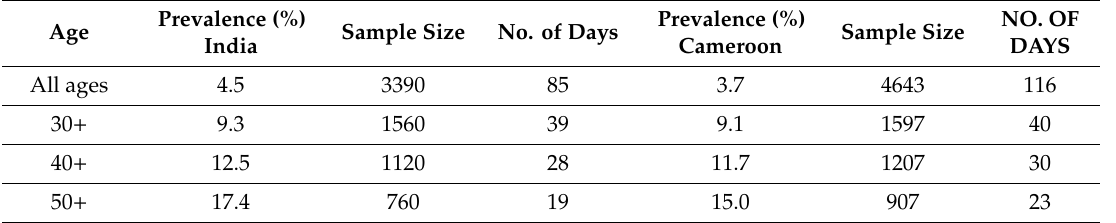
Table 2. Estimated sample size for varying age cut-o ff s in India and Cameroon and the estimated number of survey days (Using average DEFF of 1.5, cluster size of 40).